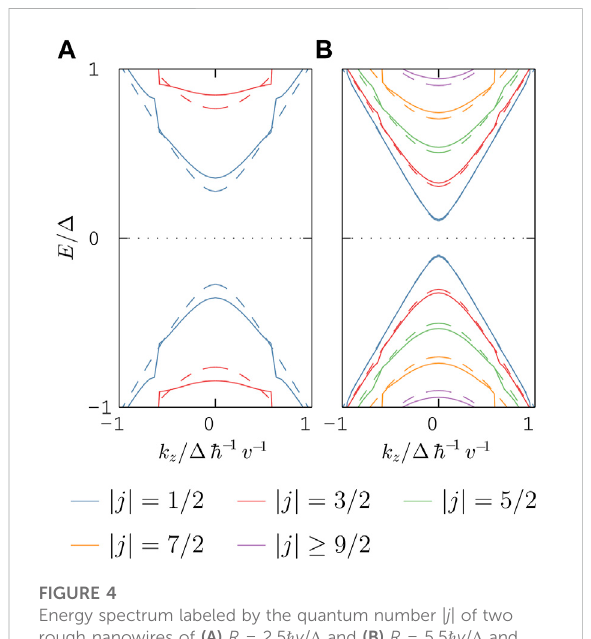
Figure 5. On each panel, the probability density of the surface state is represented as a function of the axial z and radial r coordinates, as well as a combined representation of the former in a color map. For comparison, in both panels the radial probability density of the uniform NW of R = 2.5 Z v / Δ is shown in dashed line (see Figure 3A). On the one hand, the modulation of the radius gives rise to a radial probability whose maximum values are shifted to the outermost region of the NW. On the other hand, a careful inspection of the axial